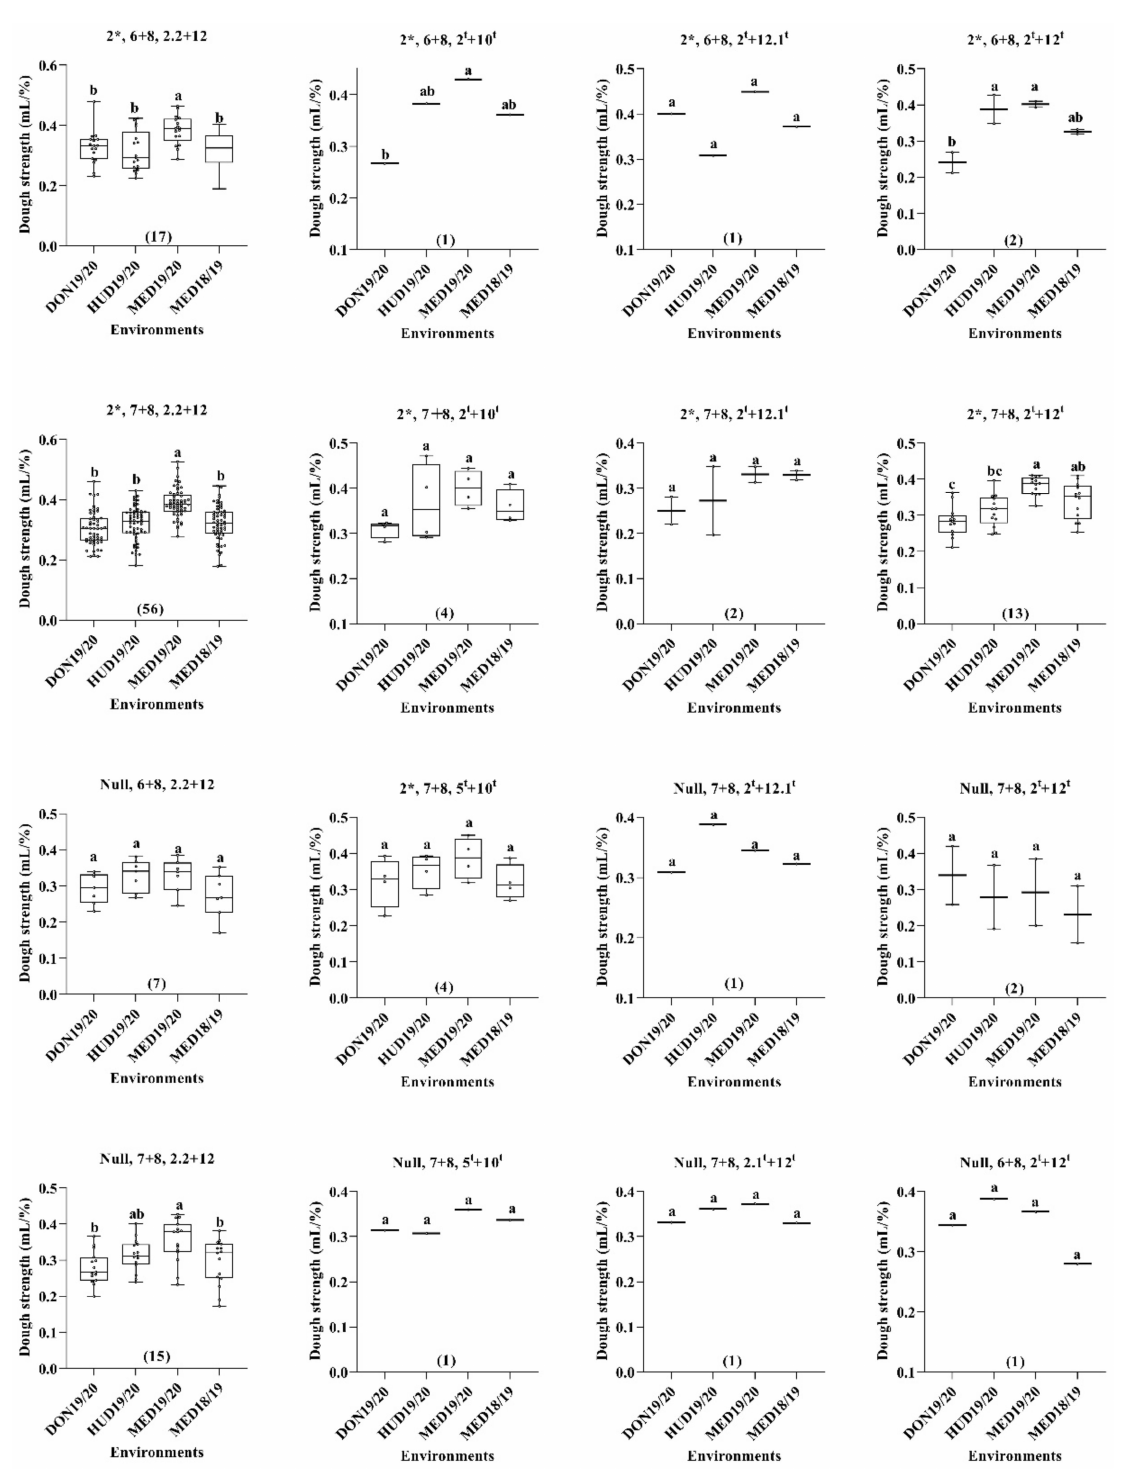
Figure 4. Box plot for the dough strength (mL/%) as affected by the HMW-GS combination across the four environments. Numbers in parentheses indicate the number of lines. Similar lower-case letters indicate that the means for the HMW-GS pairs are not significantly different according to the Tukey test at p <